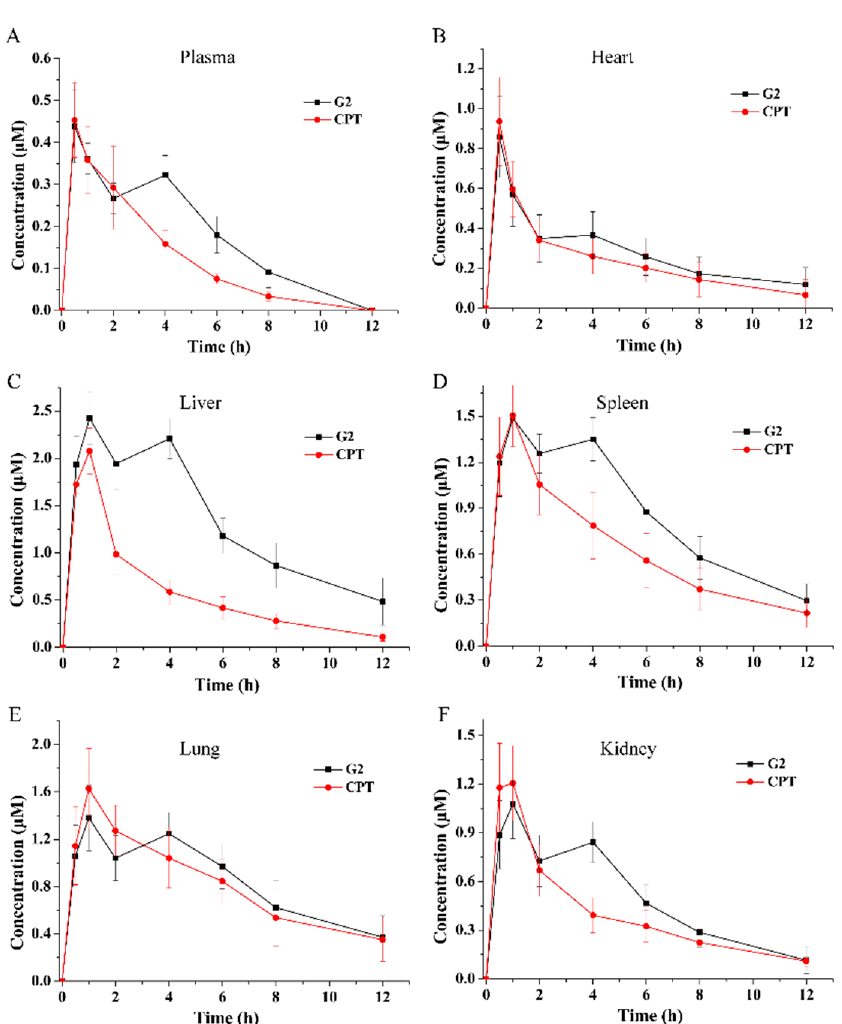
Figure 7. Total drug concentration-time profiles of G2 and CPT in plasma and organs after oral (30 mg/kg, calculated as CPT) administration: ( A ) plasma; ( B ) heart; ( C ) liver; ( D ) spleen; ( E ) lung; ( F ) kidney. Results are presented as mean ± SD of five mice. Table 1. Pharmacokinetic parameters of G2 and CPT after oral (30 mg/kg, calculated as CPT) administration (mean ± SD, n = 5).